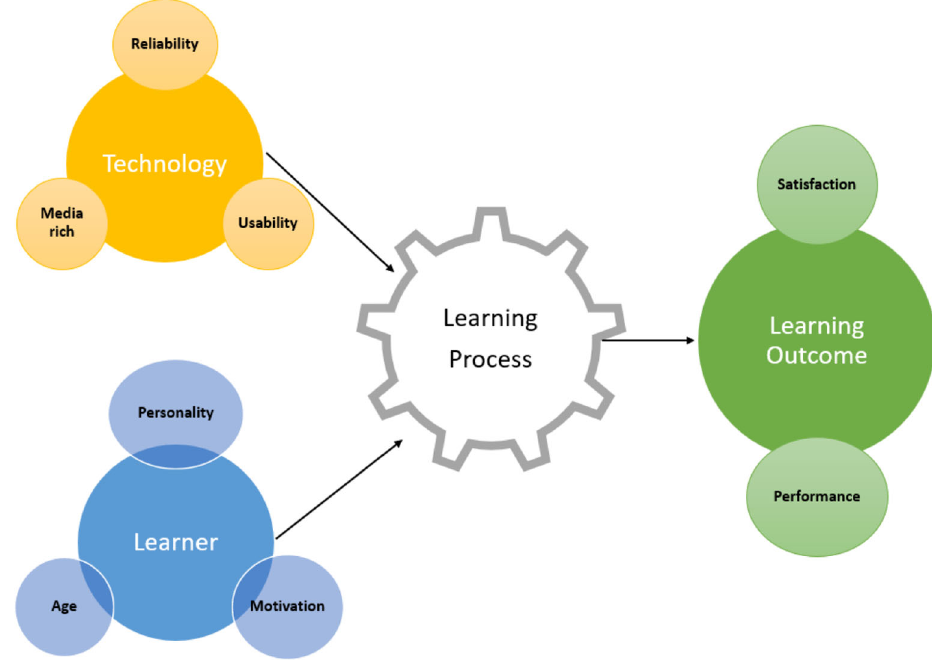
Figure 1. A model of e-learning influences and its